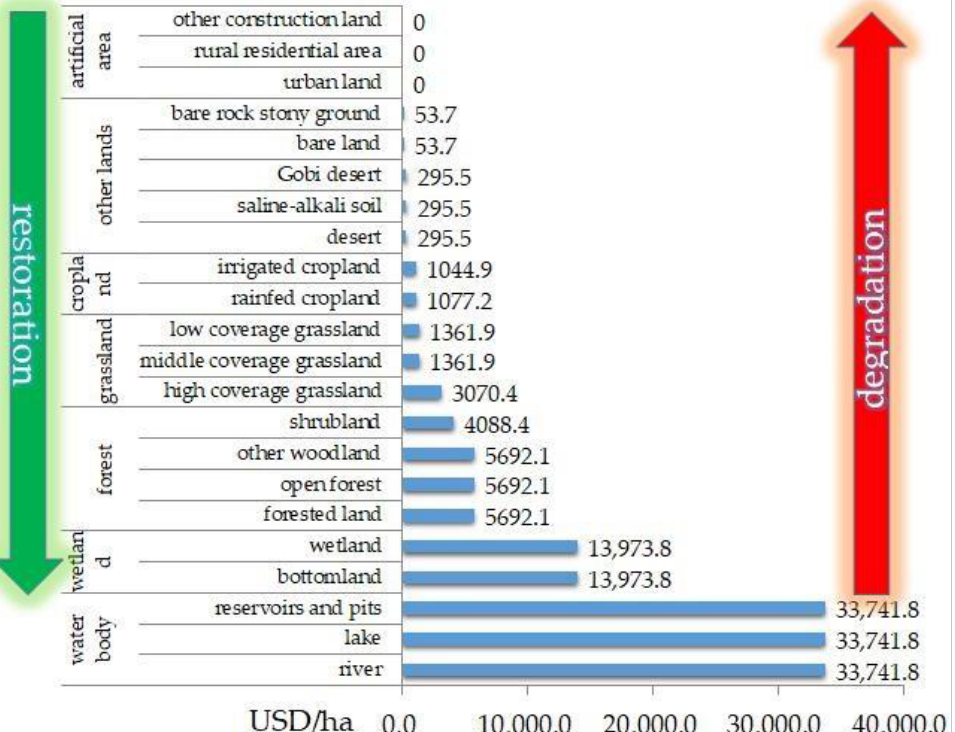
Table 3. Comparison of modified and UNCCD LUCC evaluation rules.